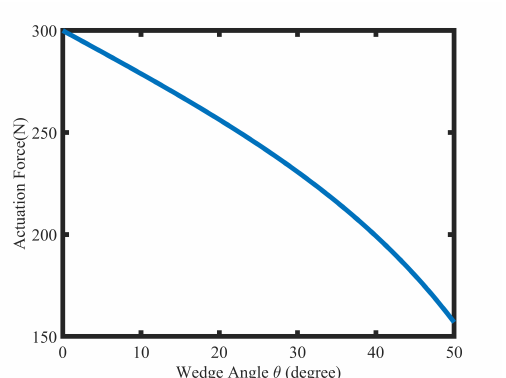
Figure 3. The relationship between the actuation force and the wedge